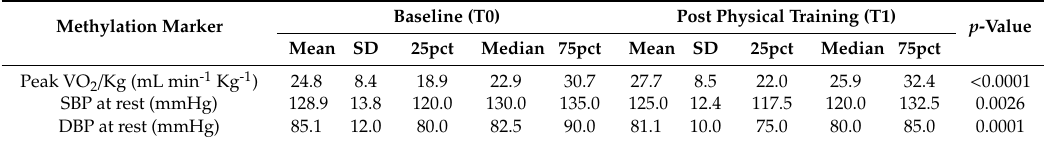
Table 2. Cardiovascular outcomes at Baseline (T0) and after Physical Training